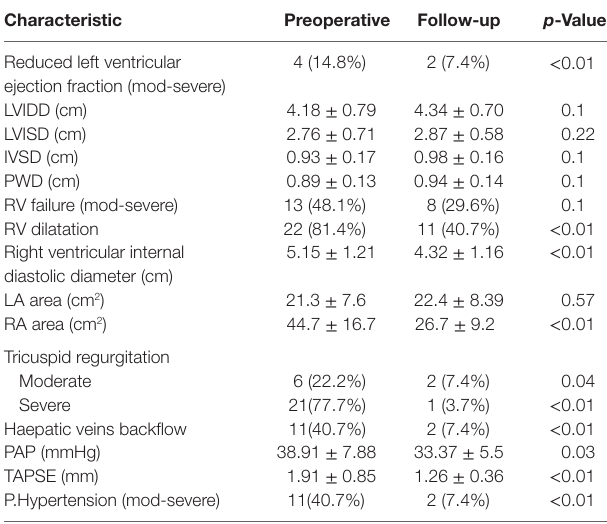
TaBle 5 | echocardiographic evaluations of patients with isolated tricuspid repair ( n = 27).